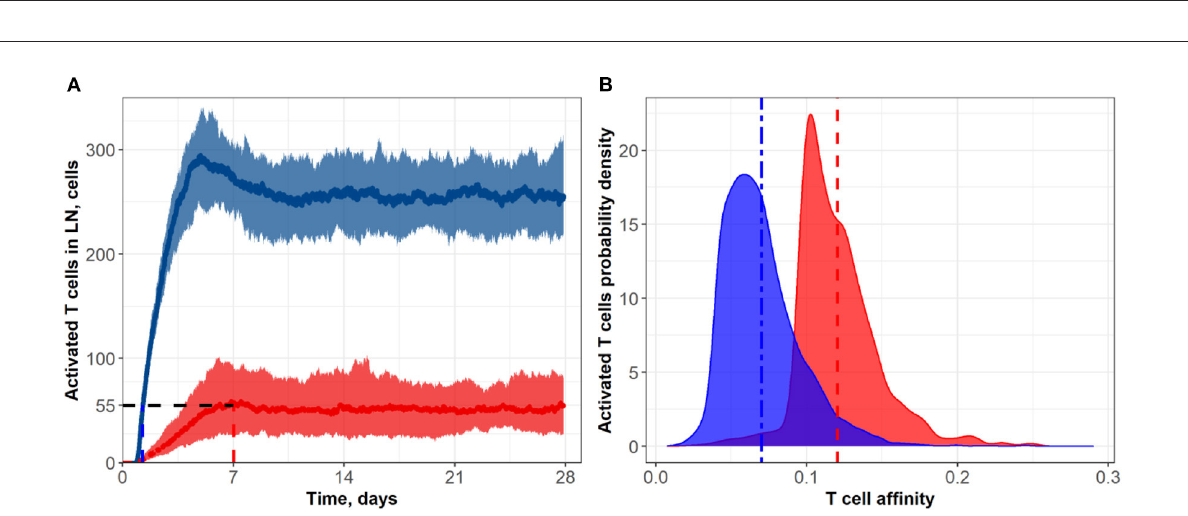
FIGURE6 (A) Population dynamics of activated T cells in the LN T zone during immune response initiation: Control conditions (red) and after administration of an anti CTLA-4-blocking antibody (blue). (B) Affinity distributions of activated T cells: Dotted vertical lines represent mean affinities for control and anti CTLA-4 conditions. Values used for simulations: α = 3, K prime = 0.1, K prolif = 0.1 (blue; anti CTLA-4 conditions); and α = 1, K prime = 0.2, K prolif = 0.2 (red; control conditions). Corresponding data files are available at the free repository GitHub at: https://github.